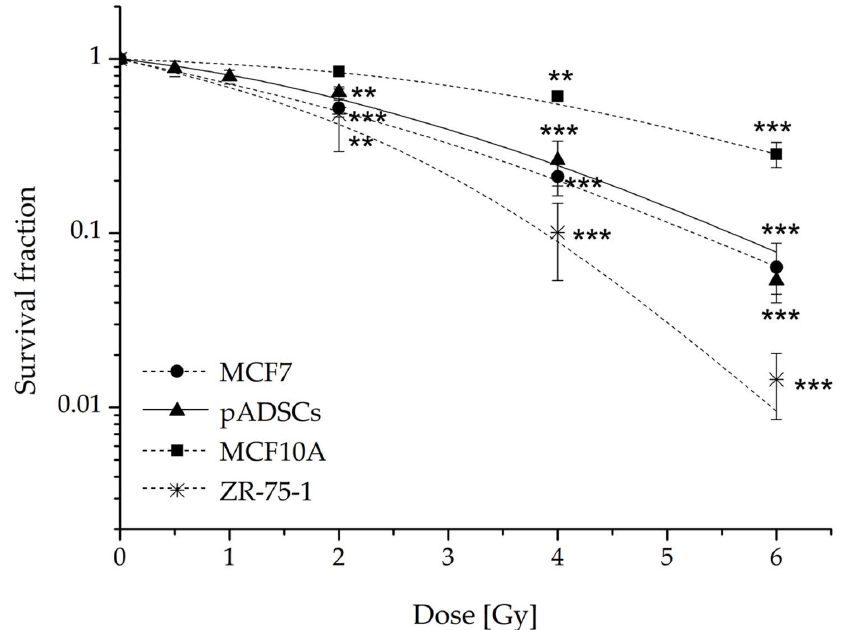
Figure 2. Colony-forming efficiency assay of pooled adipose-derived stem cells (pADSCs) in comparison to MCF-7, MCF10A, and ZR-75-1 cells. ADSCs of 10 donors were pooled and, like ZR-75-1, MCF-7, and MCF10A cells, seeded 24 h before the IR procedure, where 0 Gy was defined as the control. The cells were stained by crystal violet to visualize formed colonies. The cell survival fractions (SF) of the different experimental approaches were normalized to those of unirradiated cells; n = 5 (MCF-7 cells and ZR-75-1 cells), n = 4 (pADSCs), or n = 3 (MCF10A cells) presented as mean ± standard deviation. Asterisks illustrate significance: ** p < 0.01; *** p < 0.002 (one sample t